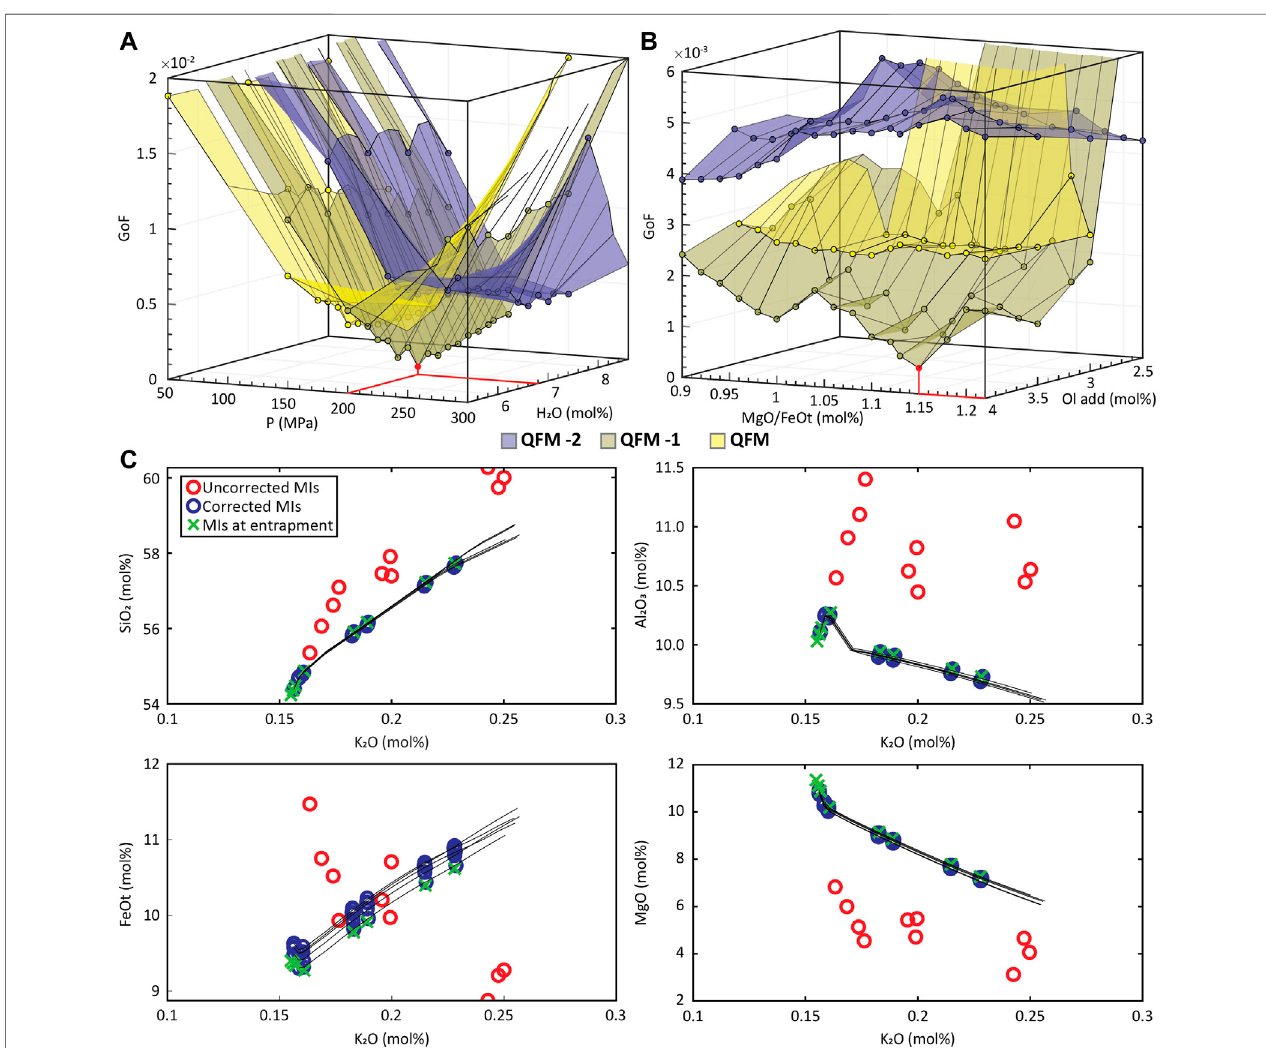
FIGURE 4 | MushPEC output of the test on the synthetic MI set of Figure 1 of the main text. (A) Minimum GoF behavior with changes in P and H 2 O content. Each colored surface corresponds to a condition as indicated in the fi gure. Minimum GoF is marked in red, and it is found at 200 MPa and 6.8 H 2 O in the QFM -1 surface. (B) Minimum GoF behavior with changes in olivine addition and MgO/FeOt ratio. Minimum GoF is marked in red, and it is found at 4 mol% olivine addition and 1.15 MgO/ FeOt in the QFM -1 surface. (C) Variation diagrams of the 5 best fi t models found. Red circles are the uncorrected MIs loaded into the MushPEC script, and blue circles are the corrected compositions for each of the 5 bet fi t models. Black lines are the LLD ’ s of the best fi t FC models and the green crosses are the original MI compositions before modi fi cation by the forward post-entrapment model.